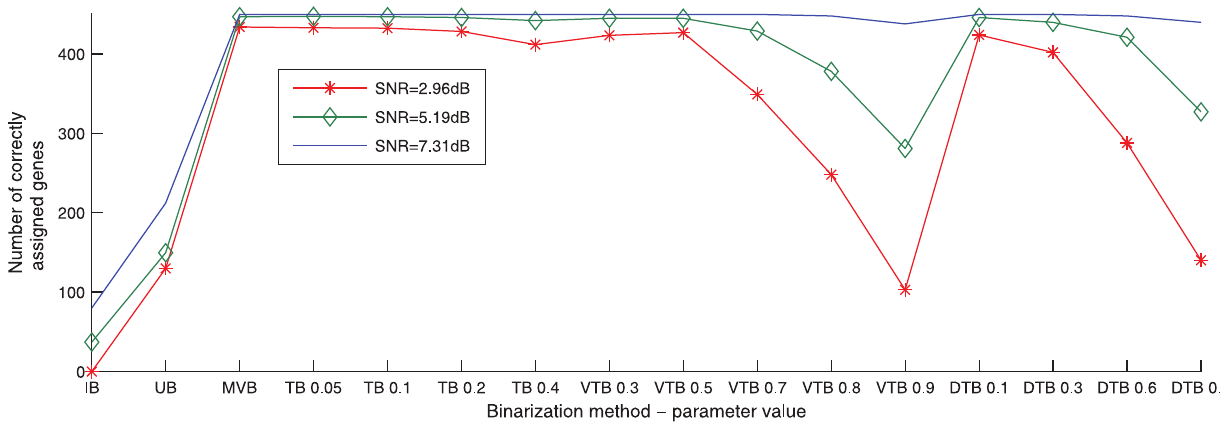
Figure 2. Correctly assigned genes. The number of correctly assigned genes at the y-axis is plotted versus the 16 binarization configurations at the x-axis for three representative synthetic datasets out of 60. It should be noted that the binarization configurations are not entirely ordered according to their tightness.